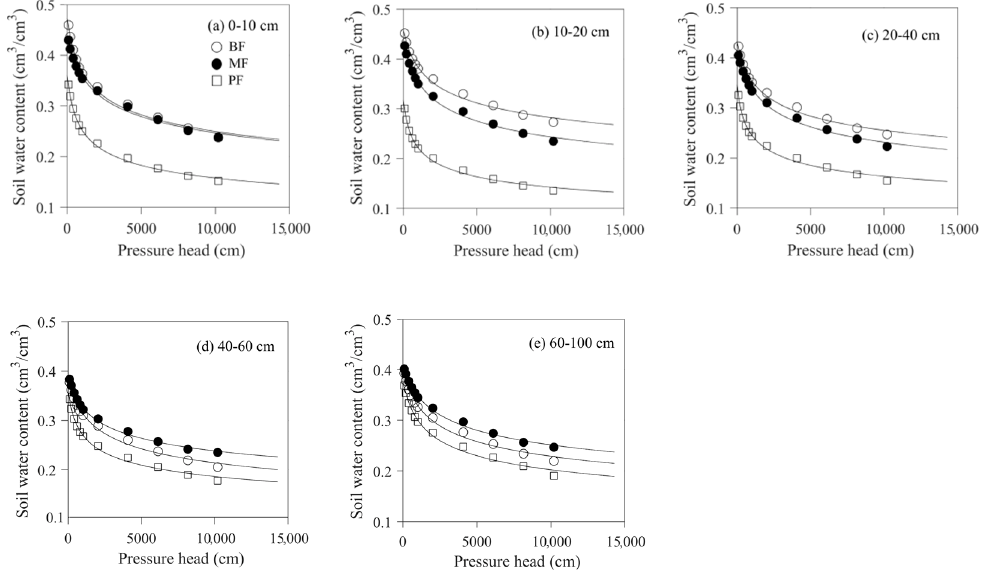
Figure 5. Soil water retention curves at depths of 0–10 cm ( a ), 10–20 cm ( b ), 20–40 cm ( c ), 40–60 cm ( d ), and 60–100 cm ( e ) in the three forests. Abbreviations: PF, Pinus massoniana forest; MF, mixed Pinus massoniana / broad-leaved forest; BF, monsoon evergreen broad-leaved forest.